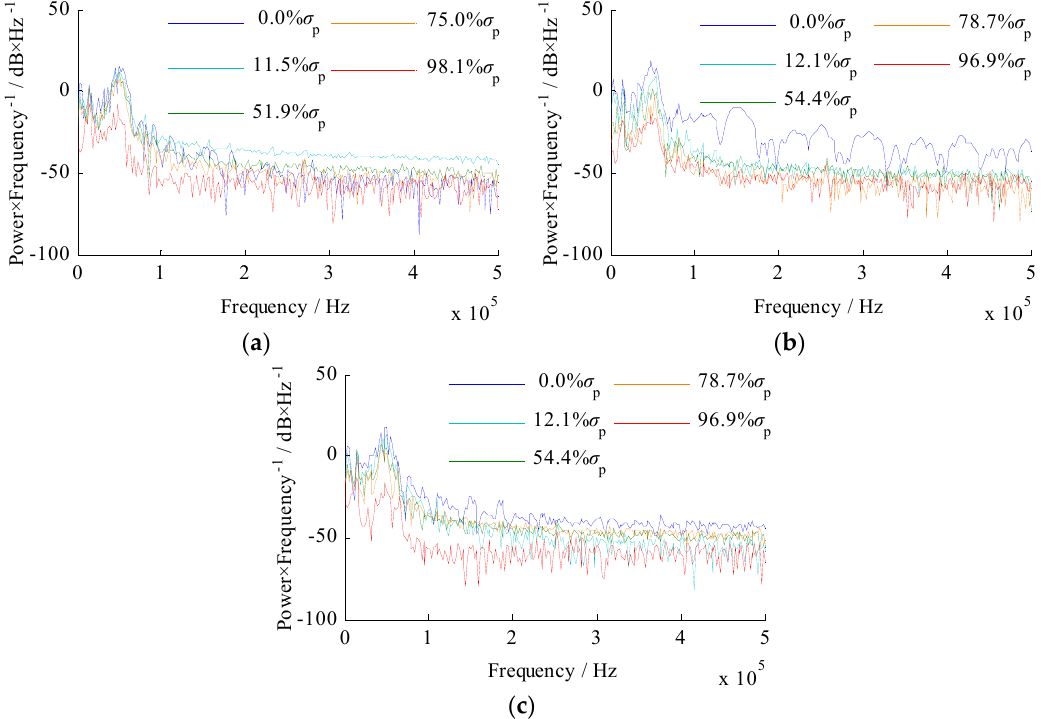
Figure 9. Power spectral density during the destruction ( a ) D2; ( b ) D3; ( c ) D4.